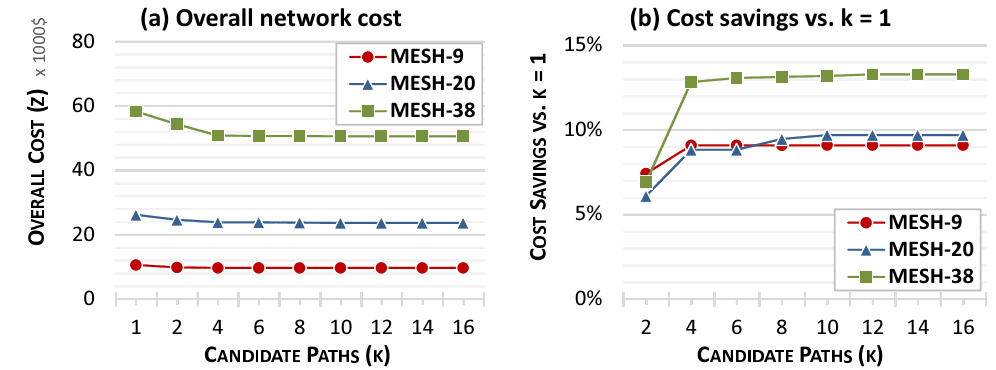
Figure 4. ( a ) Overall network cost z and ( b ) relative difference in z vs. the single-path scenario as a function of the number of candidate routing paths ( k ) in the networks analyzed; the results obtained and averaged for ρ ∈ { 1.0,1.5,2.0 } and W ∈ { 4,8 }